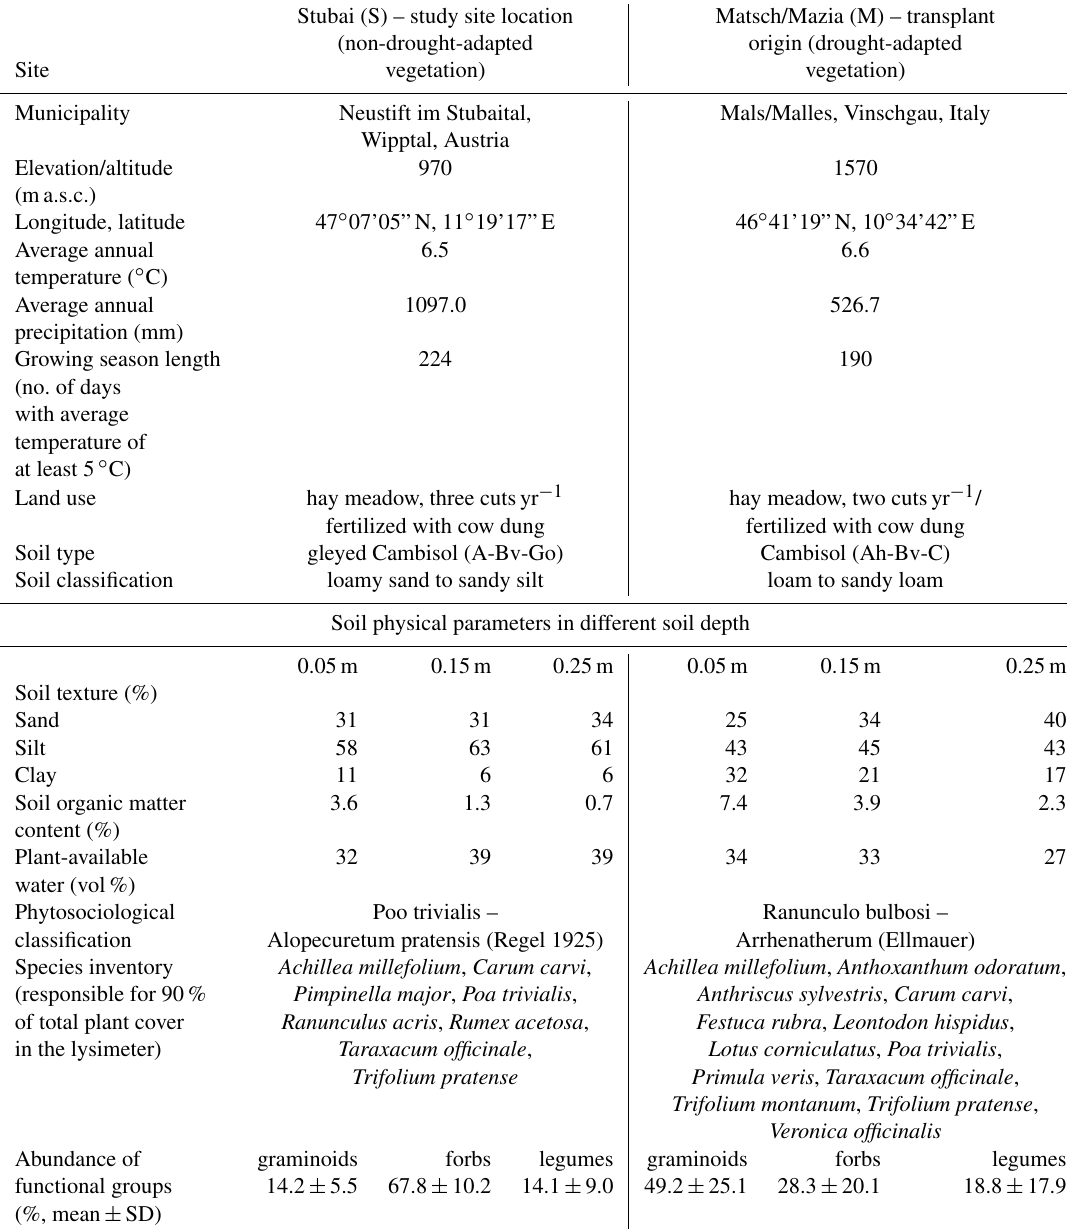
Table 1. Summary of site conditions and vegetation properties. Stubai (S) – study site location Matsch/Mazia (M) –